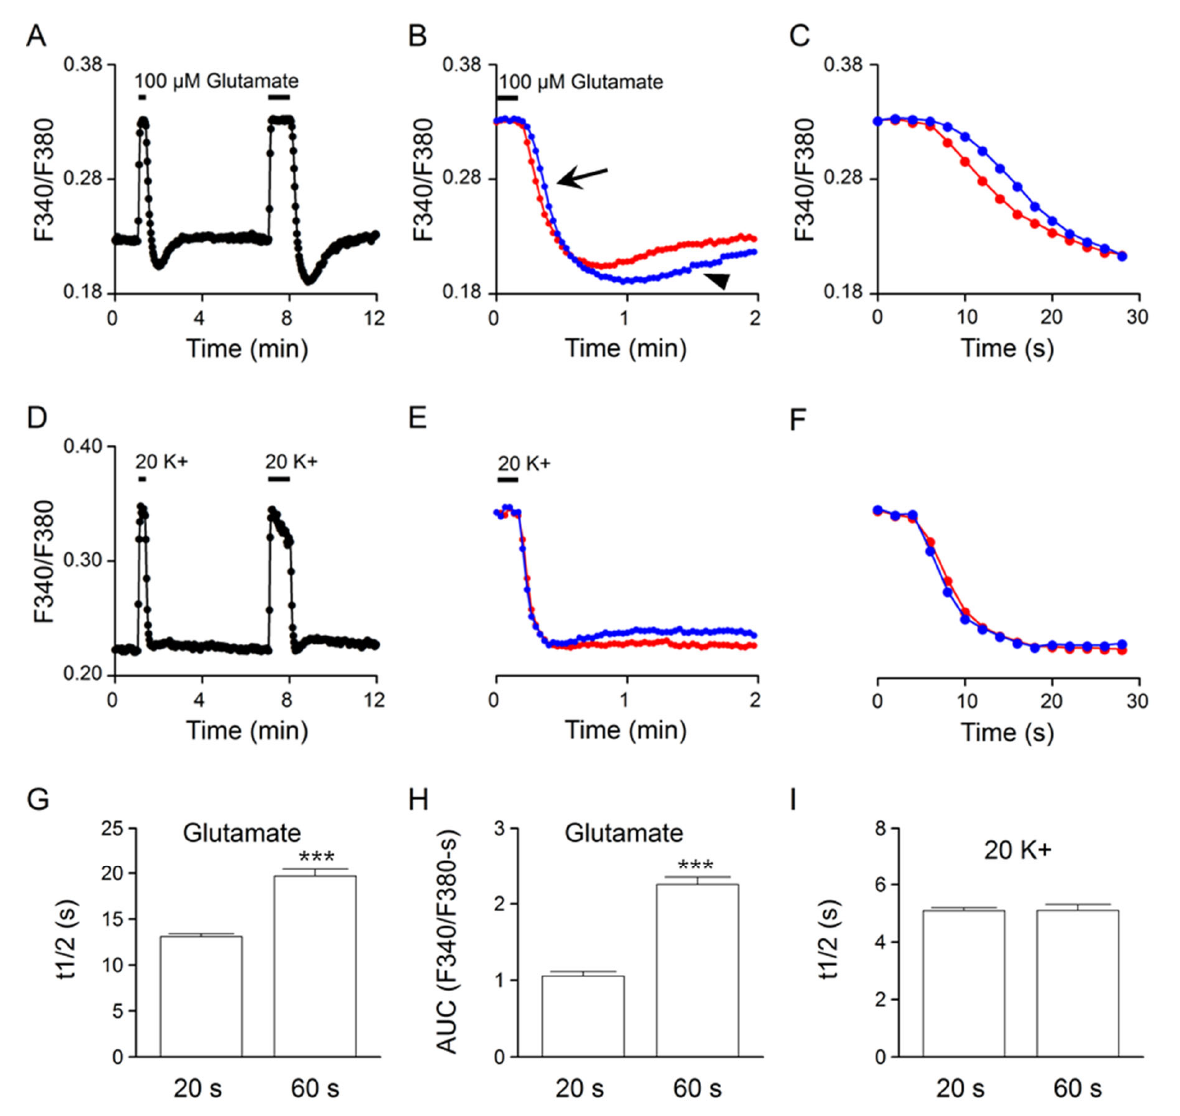
Figure 4. Effects on the Ca 2+ clearance kinetics of increasing exposure time in glutamate ( A – C ) and in 20 mM K + ( D – F ) from the same cells. ( A , D ) A representative experiment (an average of 23 cells) showing the Ca 2+ responses to 20 and 60 s applications of 100 µ M glutamate ( A ) and 20 mM K + ( D ). ( B , E ) Superimposition of the 20 s (red traces) and 60 s (blue traces) Ca 2+ responses at the end of 100 µ M glutamate ( B ) and 20 mM K + ( E ) application. Note the slower Ca 2+ decay (marked by the arrow) and the larger and more prolonged rebound Ca 2+ suppression (marked by the arrowhead) for the 60 s glutamate response ( B ). ( C , F ) Expanded time course of Ca 2+ decay for better comparing the 20 s (red traces) and 60 s (blue traces) Ca 2+ responses to 100 µ M glutamate ( C ) and 20 mM K + ( F ). ( G , H ) Statistics showing the effects of 20 s and 60 s glutamate application on the Ca 2+ half-decay time (t 1/2 ) ( G ) and the rebound Ca 2+ suppression, as measured by the area under the curve (AUC) ( H ). Note the larger t 1/2 and AUC values for the longer 60 s glutamate response. ( I ) Statistics showing a similar t 1/2 for the Ca 2+ responses to 20 s and 60 s 20 mM K + application. *** p < 0.0001.